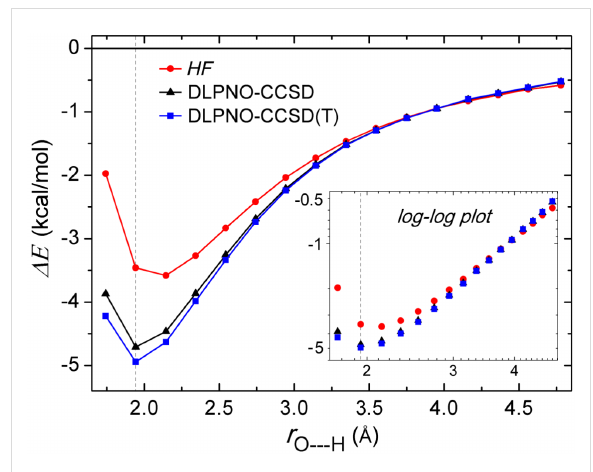
Figure 3: Dissociation curve of Conf1 of water dimer as a function of the H-bond distance. Its nearly linear relation in the log–log scale for the long range is shown as insert on the graph. The black dotted vertical line at 1.943 Å corresponds to the equilibrium r e (O---H) dis- tance.